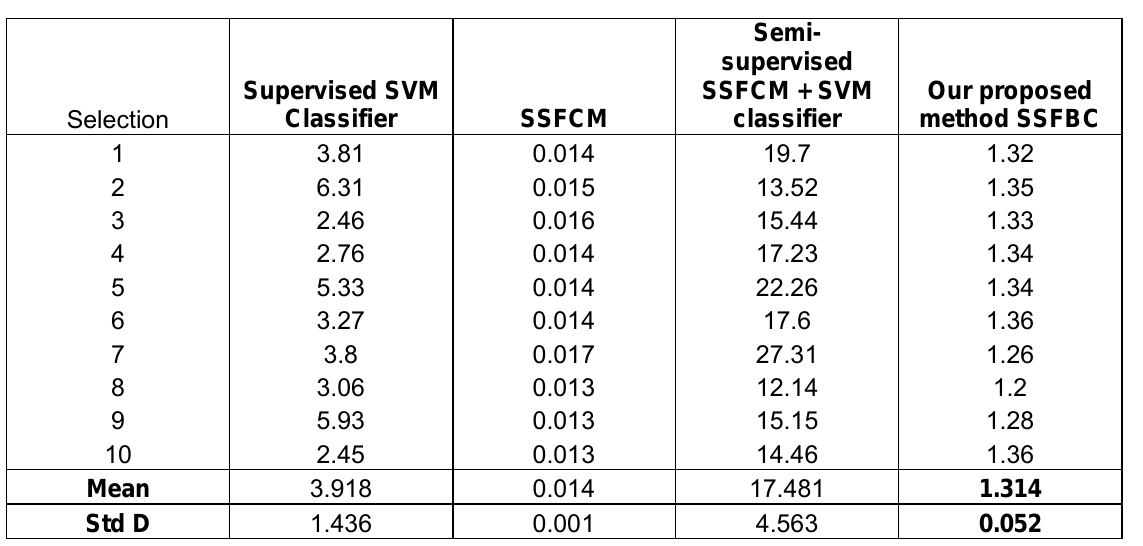
Table 4. Computational time spent for labelling Wine Dataset